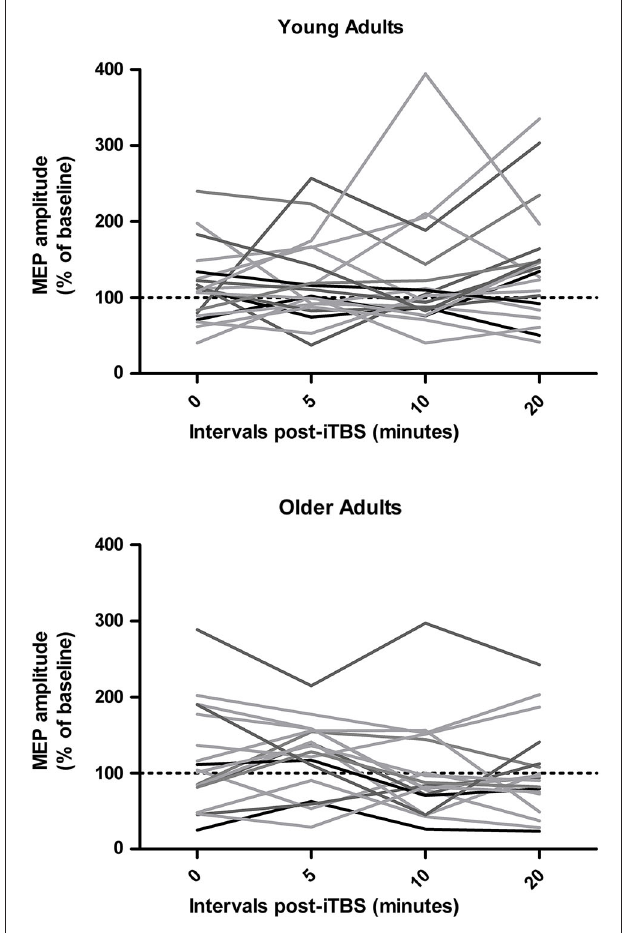
FIGURE 1 | Individual responses to intermittent theta burst stimulation (iTBS) in young and older adults at 0, 5, 10, and 20 min post-iTBS .